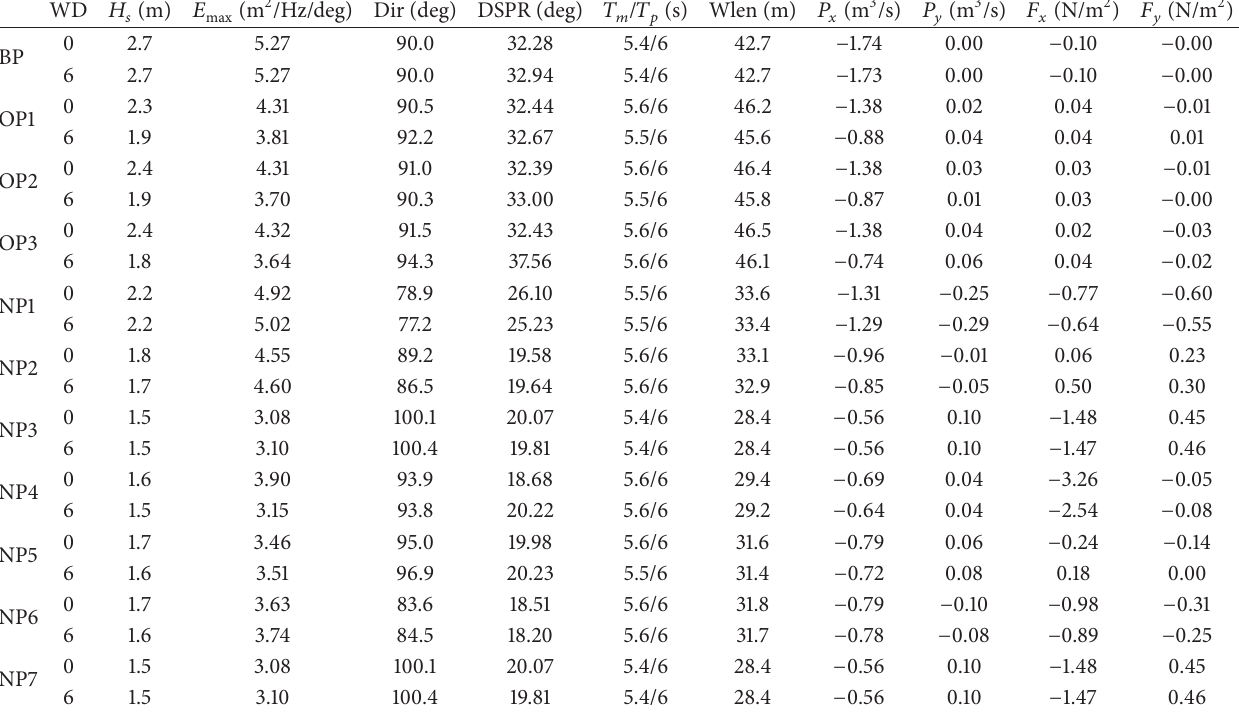
Table 3: CS2 ( 𝐻 𝑠 = 3 m, 𝑇 𝑚 = 6s, and Dir = 90 ∘ ), evaluation of the impact of the energy farms on the waves in the reference points OP1, OP2, OP3, and